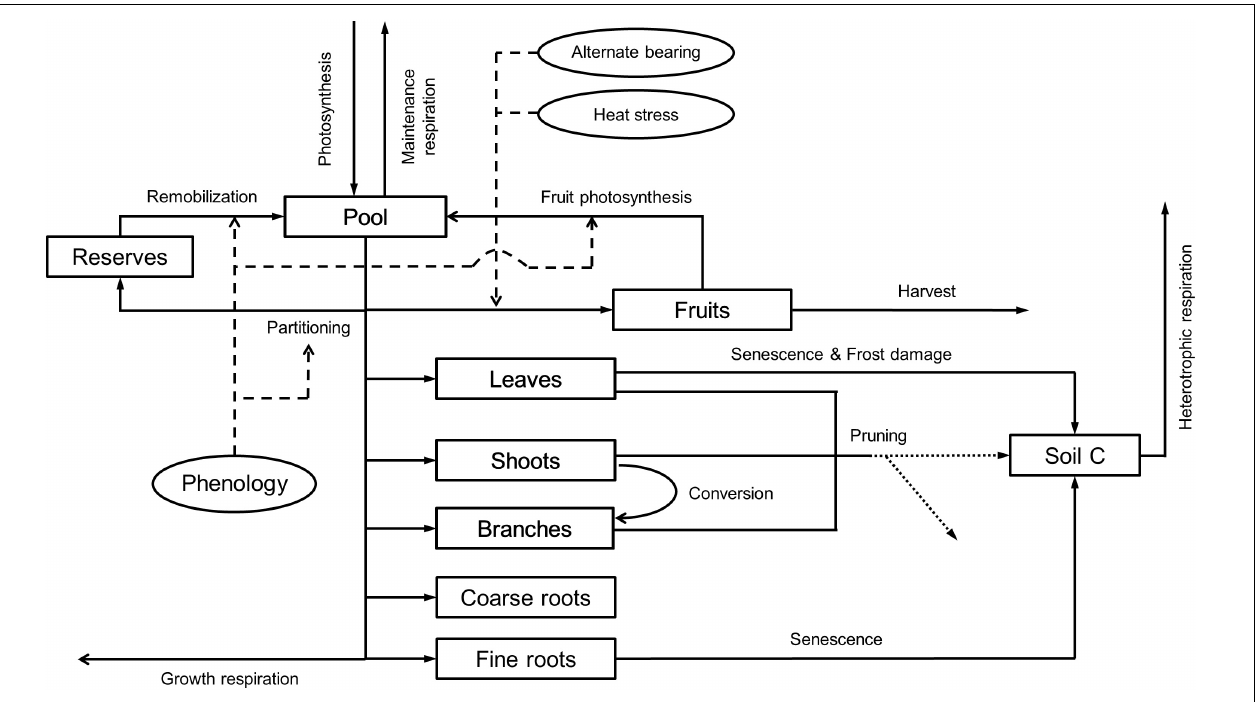
FIGURE 2 | Relational diagram of the carbon balance component, highlighting the processes simulated. Squares represent carbon stocks and solid arrows the fluxes of carbon through the system. Circles and thin dashed arrows indicate key factors determining the calculation of some fluxes. Pruning residues can either be incorporated into the soil or exported, at user’s choice (dotted